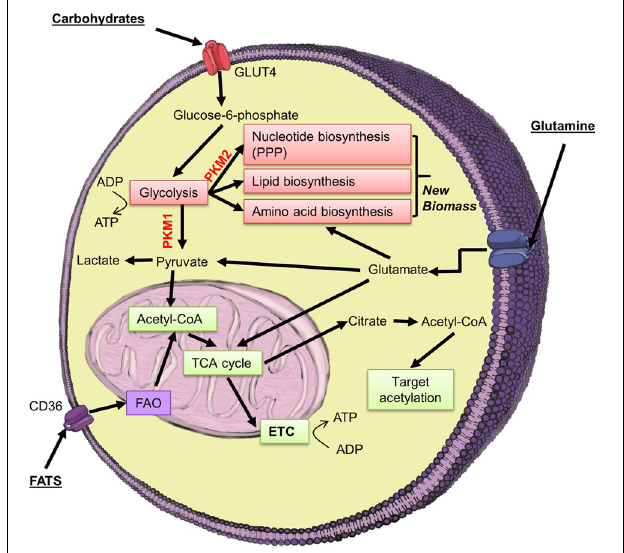
FIGURE 3 | Highly proliferative cell populations, such as some tumors, ESCs, iPSCs, and SCs require a ready supply of carbon and nitrogen for the generation of new biomass (nucleotides, proteins, phospholipids). To achieve this, many highly proliferative cell populations switch to a predominantly glycolytic based metabolism, but upregulate the PKM2 splice isoform of pyruvate kinase. In this manner, proliferating cells can build up sufficient glycolytic intermediates for the biomass necessary for cell